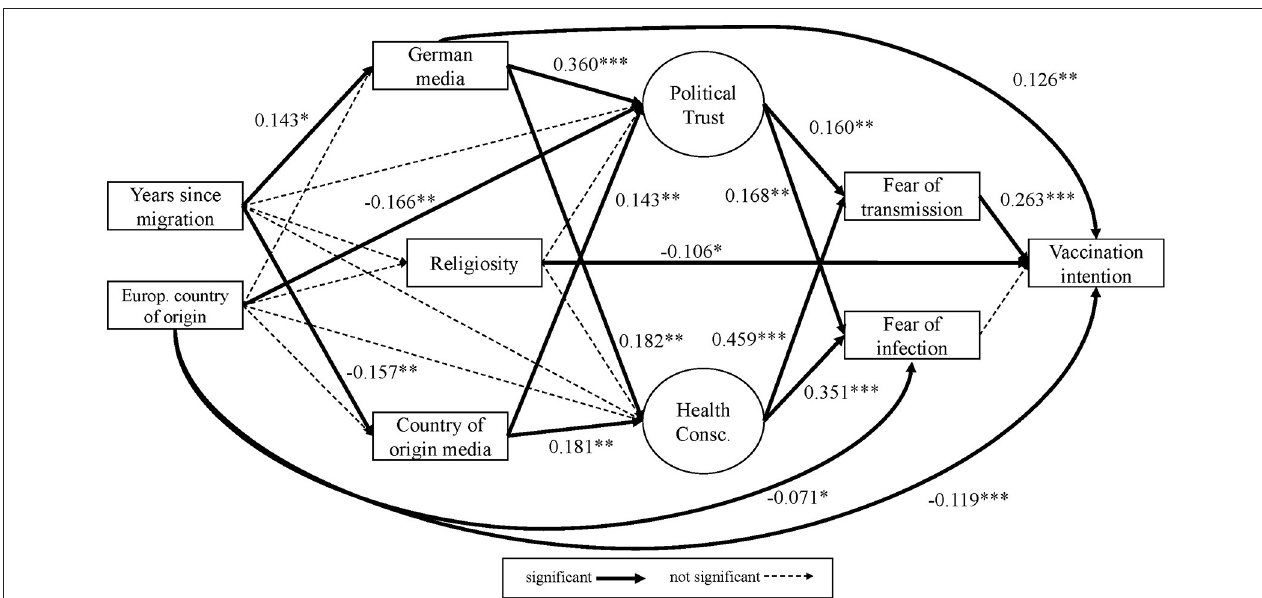
FIGURE 5 | Empirical model 2 + –migrants only (standardized) with additional paths as suggested by modification